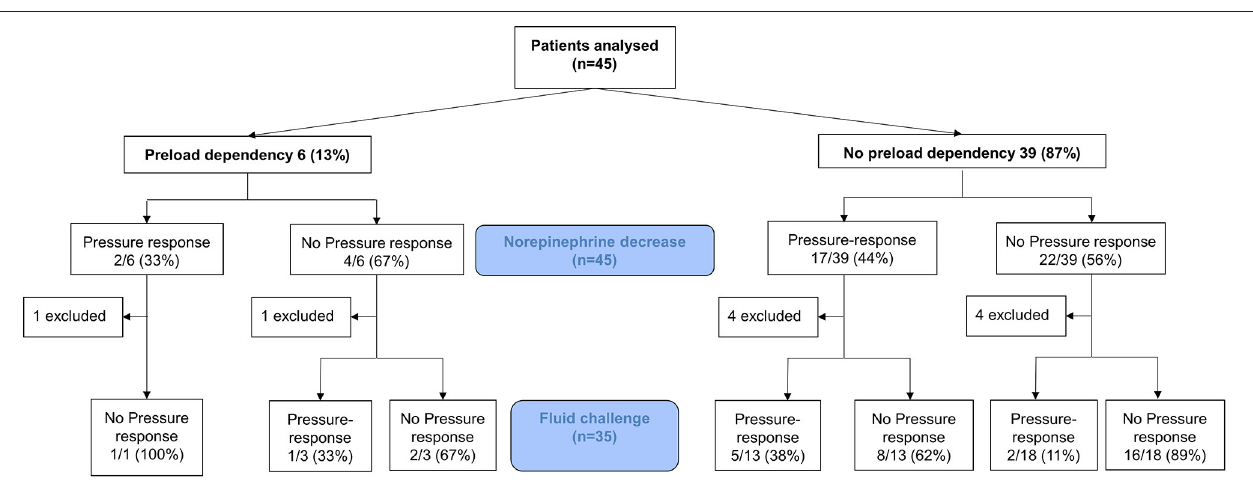
FIGURE 1 | Flow chart of the